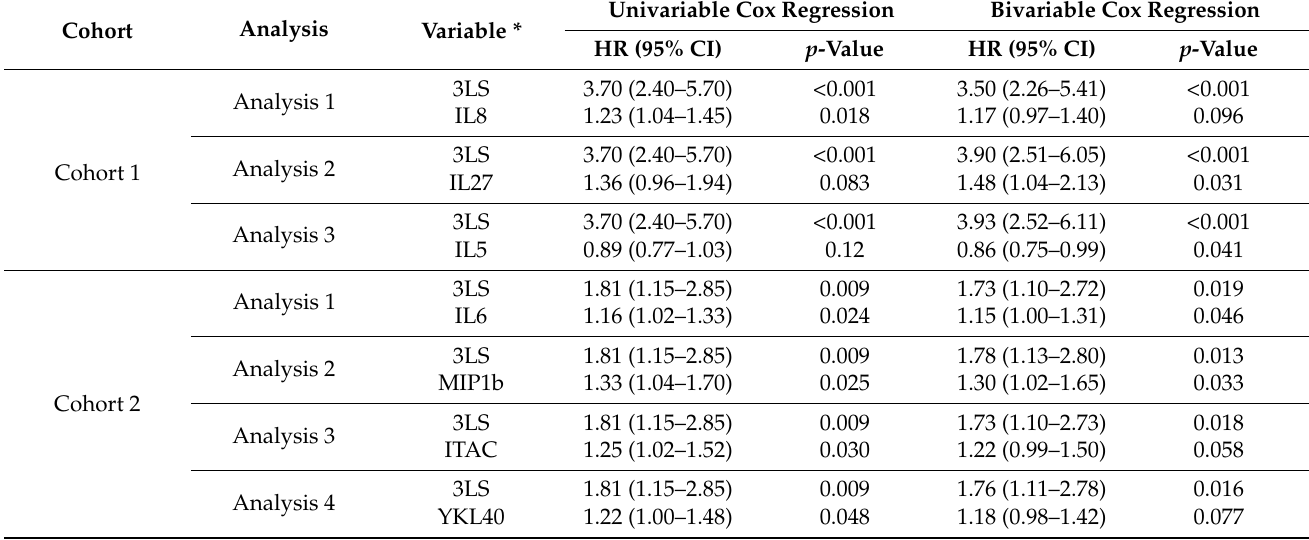
Table 2. Bivariable cox regression of the poor prognostic 3-lipid signature (3LS) with cytokines.